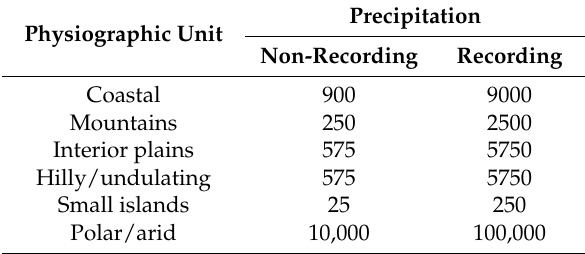
Table 3. Recommended Minimum Densities of Stations (Area in per Station)